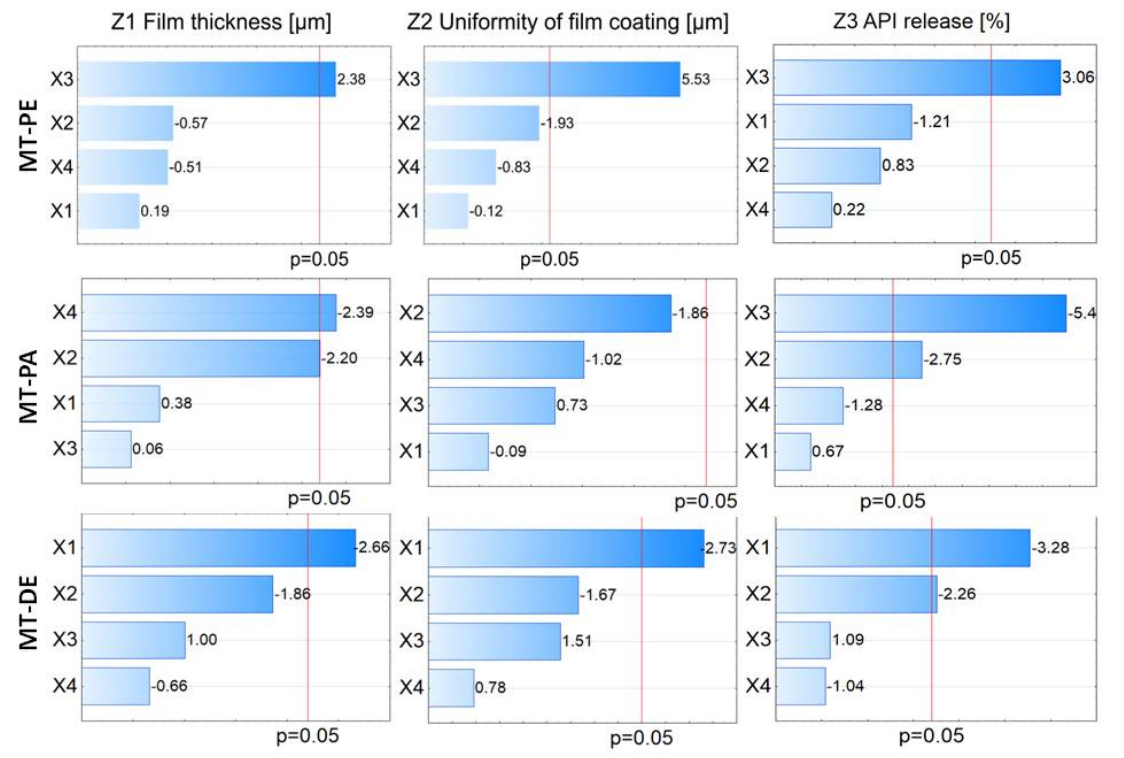
Figure 3. Pareto charts of the main effects for the fluid bed coating process of MTs.